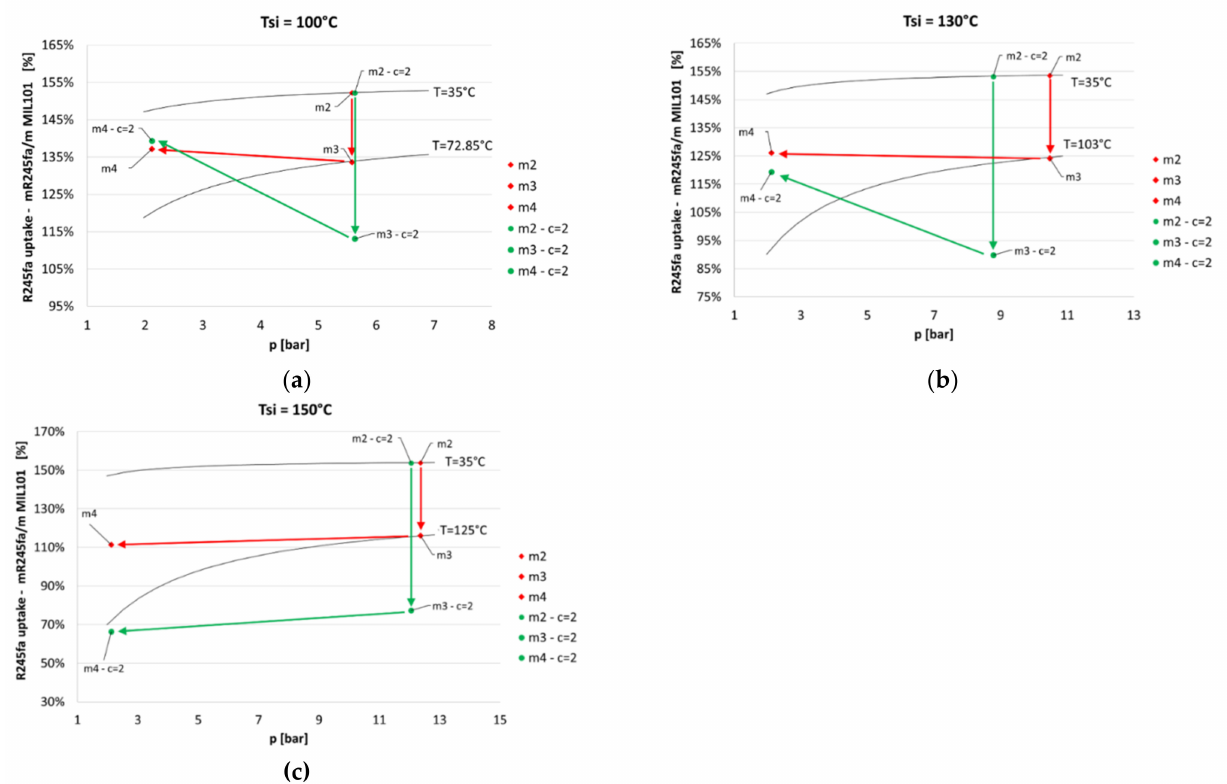
Figure 8. Comparison between the MIL101 (red) uptake and a theoretic MIL101 (green) with double uptake in the optimal conditions for heat source temperatures of 100 ◦ C ( a ), 130 ◦ C ( b ) and 150 ◦ C ( c